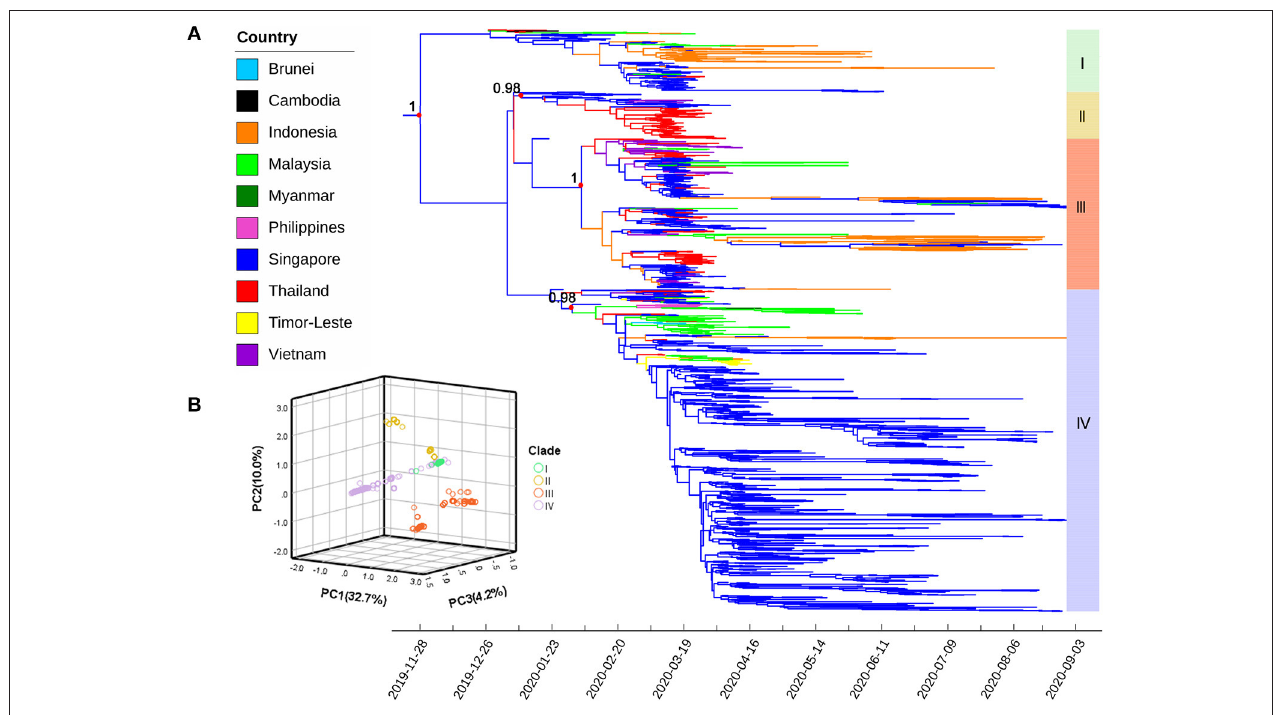
FIGURE 2 | (A) Maximum clade credibility (MCC) tree of severe acute respiratory syndrome coronavirus 2 (SARS-CoV-2) strains isolated from Southeast Asia using complete genomes. Colors indicate different sampling locations. Red dots represent key nodes; the corresponding posterior probability values ( > 0.95) are indicated. (B) The plot of the first three principal components (PCs) from the principal component analysis based on genomic variations; sample clustering is roughly in agreement with the MCC tree. Four major clades (I–IV) are marked with the same color scheme in both figures.